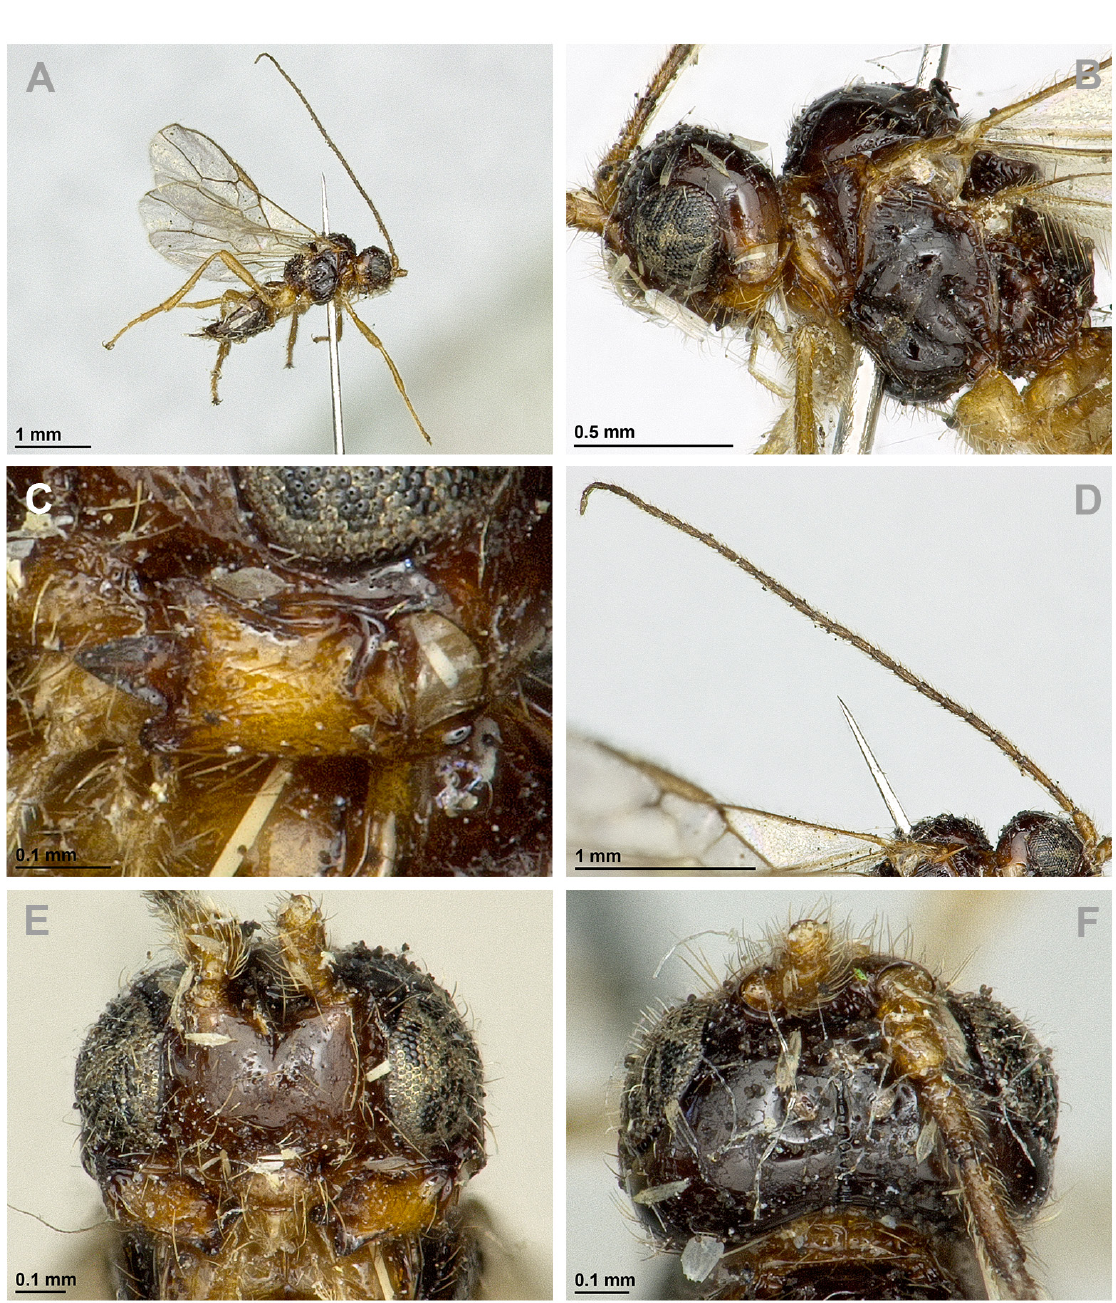
Fig. 50. Asobara robusta van Achterberg, sp. nov., ♀, holotype (RMNH 7597). A . Habitus, lateral view. B . Head and mesosoma, lateral view. C . Mandible. D . Antenna. E . Head, front view. F . Head, dorsal